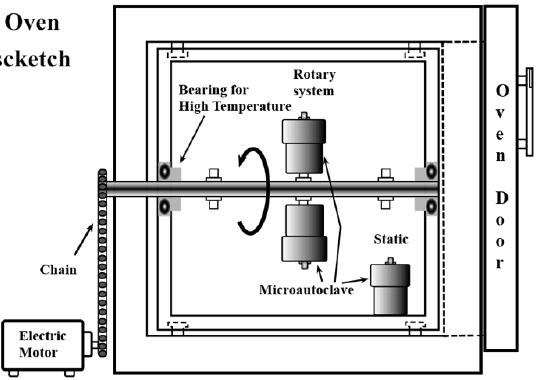
Figure 1. Scheme of the experimental oven used for carrying out the hydrothermal treatments under stirring and static conditions. stirring and static